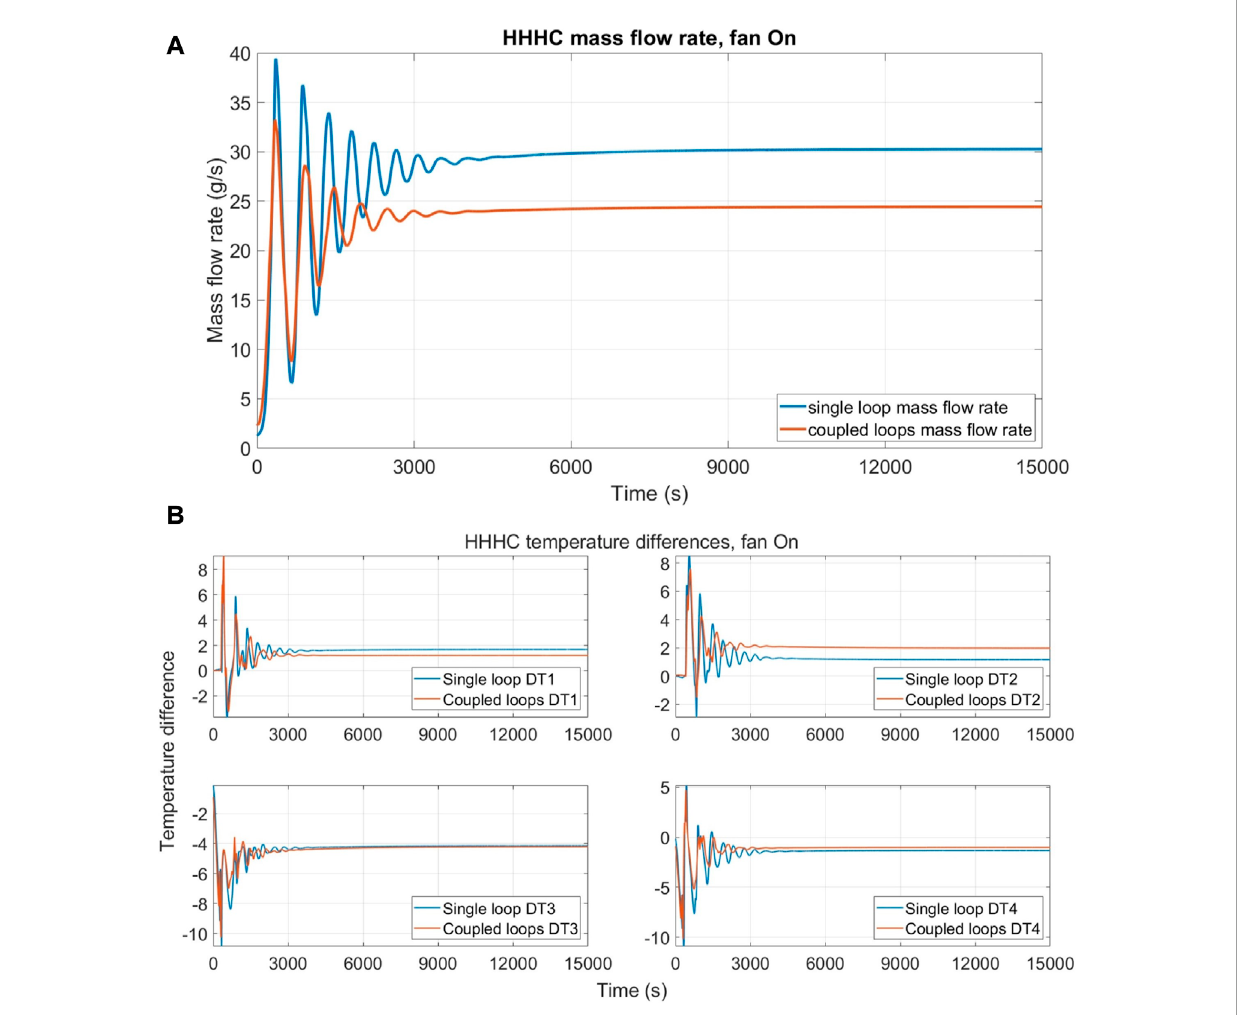
FIGURE 12 Comparison between single DYNASTY and coupled loop simulations with 0% fan speed for VHHC configuration; (A) mass flow rate evolution and (B) temperature difference